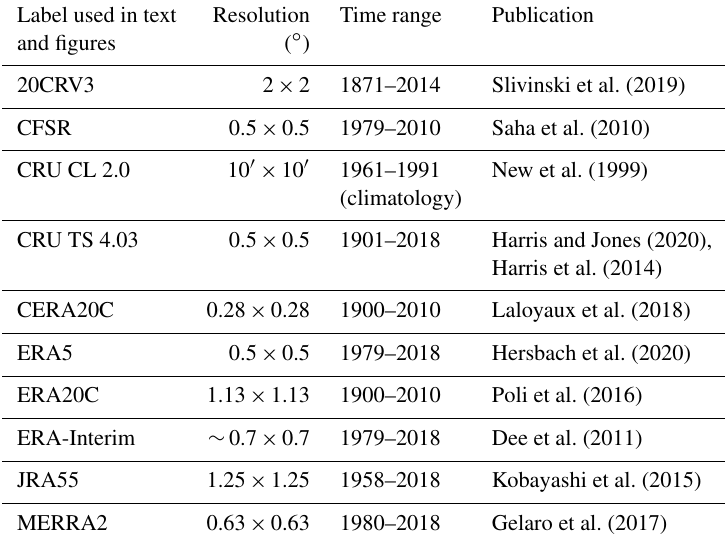
Table 1. Resolution and time range of the meteorological data sets used as boundary conditions.